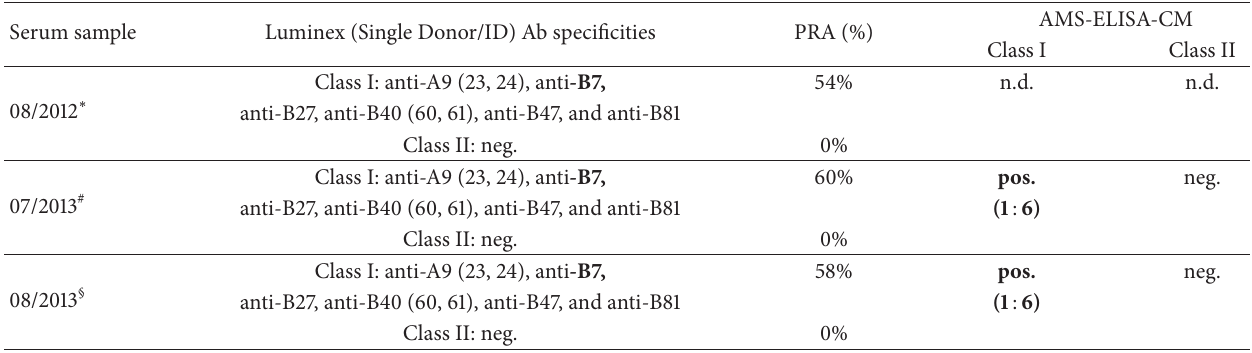
Table 1: Results of Luminex-based anti-HLA antibody specification analyses and corresponding outcomes of the AMS-crossmatch ELISA for the 42-year-old lung recipient highlighting an involvement of anti-HLA DSA (anti-HLA-B7). Serum sample Luminex (Single Donor/ID) Ab specificities PRA (%)